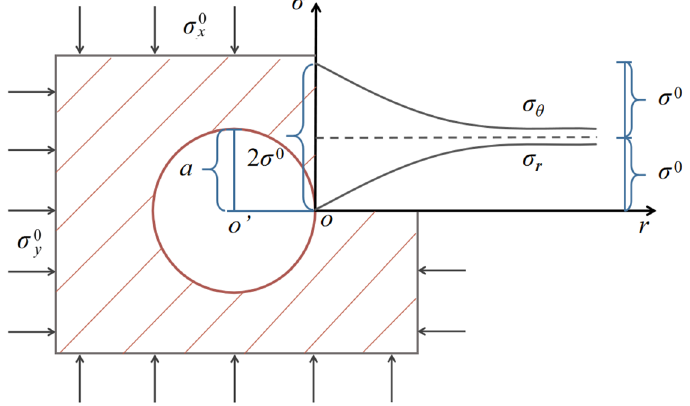
Figure 1. Elastic stress distribution for the surrounding rock of the deep tunnel cross section. Equation (1) is simplified as follows when the homogeneous initial stress field is con- sidered isotropic and no support is used for the surrounding rock around the excavation opening ( σ 0 = σ 0 = σ 0 , τ r θ = 0 and F s = 0): x y